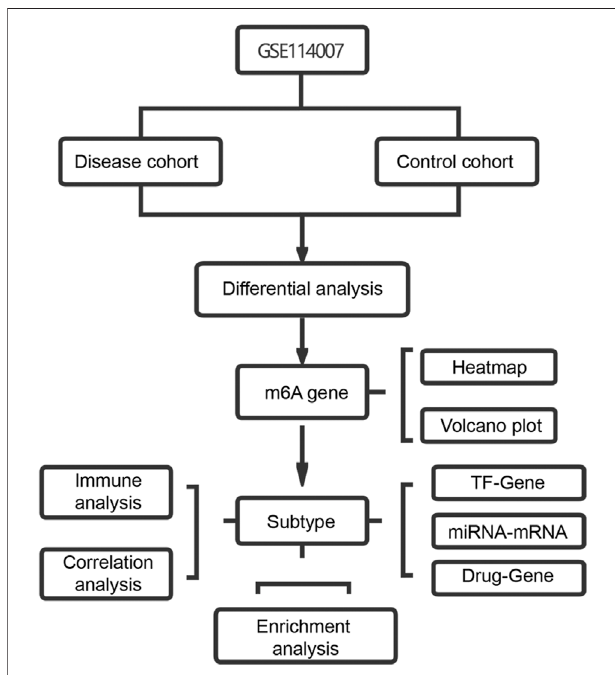
FIGURE 1 | Study fl ow